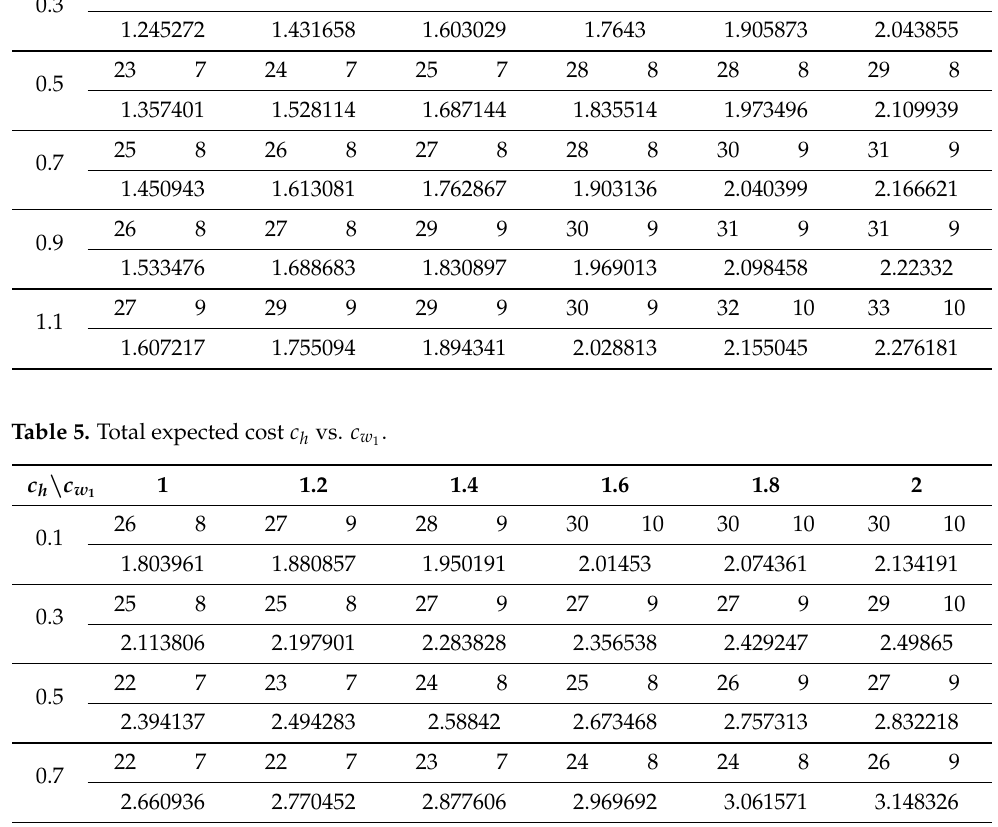
Table 4. Total expected cost c w